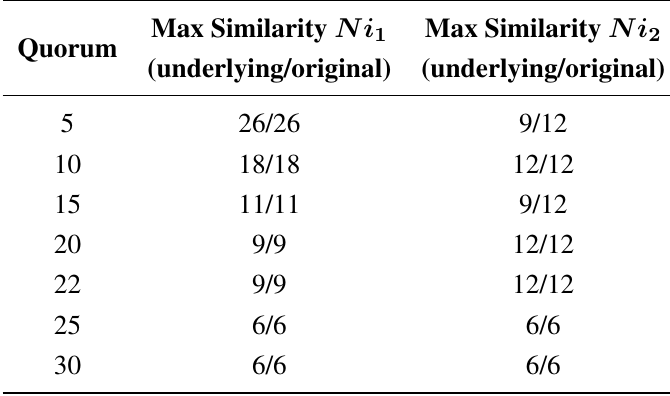
Table 5. Normalized maximum similarity with the reference patterns of the family nickel-dependent hydrogenases, for different